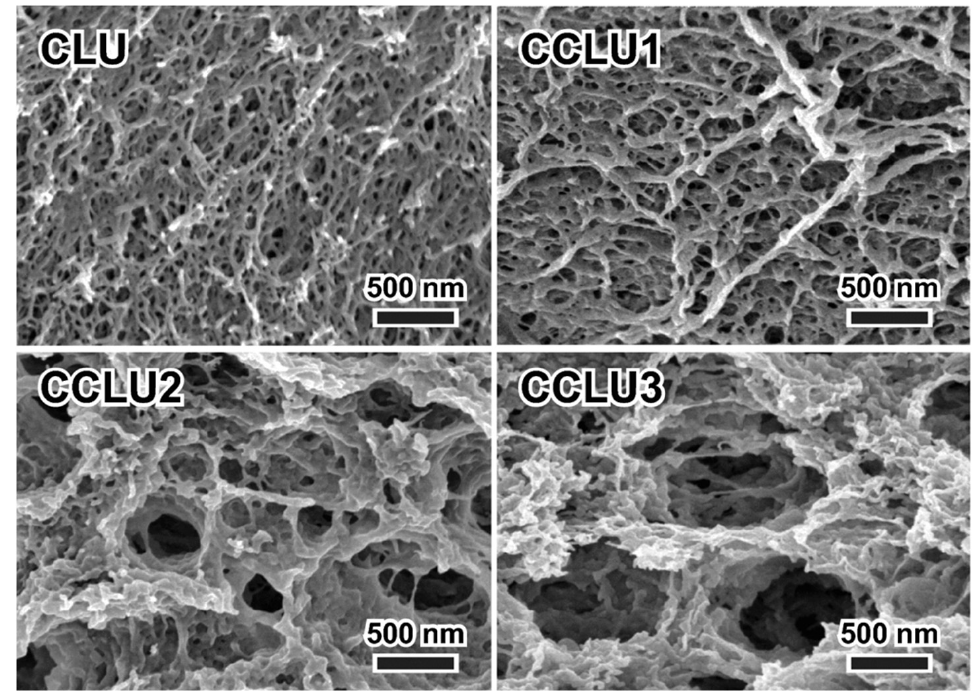
Figure 9. Porous structures of freeze-dried gels prepared using an aqueous LiOH/urea solution for co-dissolution of cellulose and chitosan (CLU: pure cellulose, CCLU1-3 hydrogels with increased amounts of chitosan from 25 to 75%)